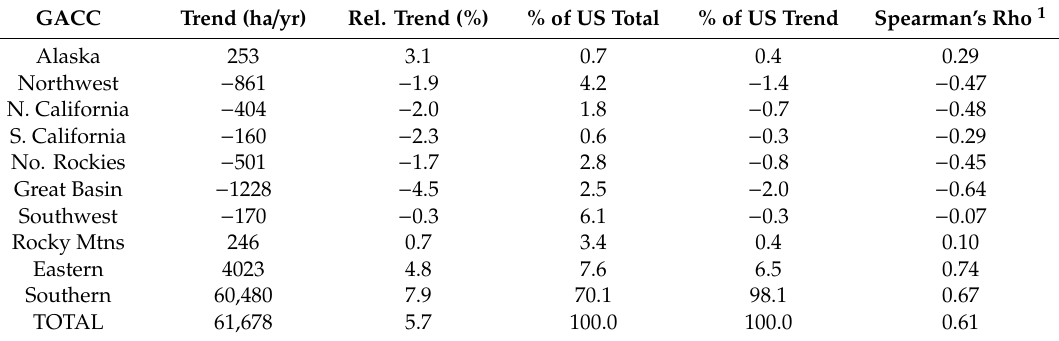
Table 1. Trends in prescribed fire accomplishments in the United States (US) by Geographic Area Coordination Center region (GACC) from 1998 to 2018, including raw trend (mean ha / year), relative trend (normalized by mean accomplishment for a given GACC), percent of the total US accomplishment, percent of the total US trend, and Spearman’s Rho to indicate the strength of the